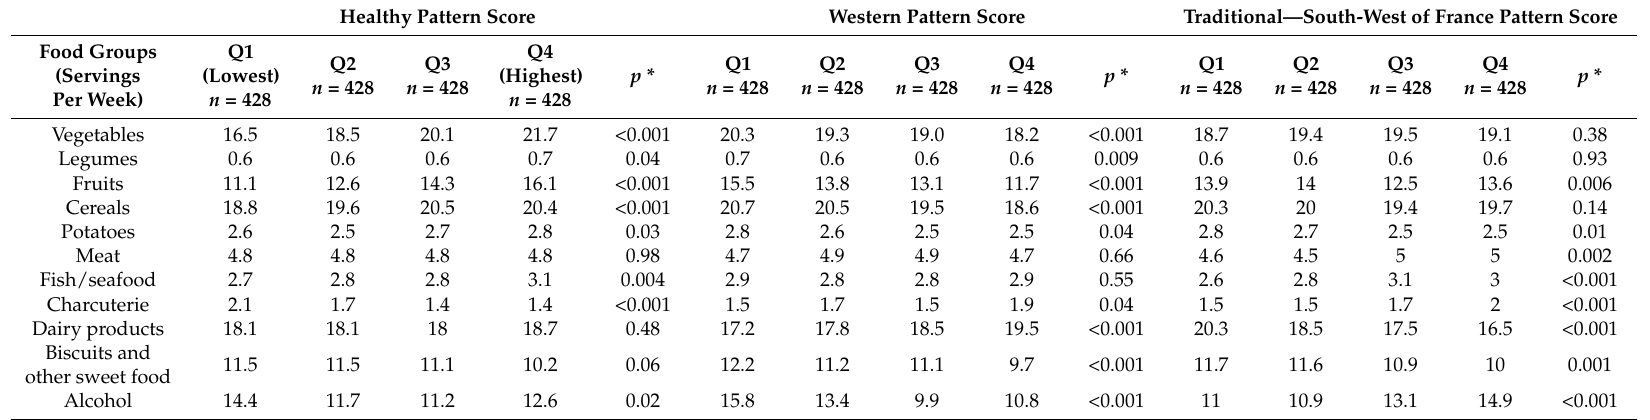
Table 3. Mean food group intakes according to quartiles of component scores obtained by factor analysis—principal component analysis of nutrient intake data in 3C ( n = 1712), from food frequency questionnaires.